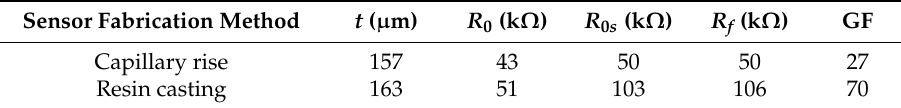
Table 2. Characteristics of the sensors produced via capillary rise and through the resin casting method: average thickness t , initial resistance R 0 before the cyclic test, starting resistance R 0 s before the monotonic test, final resistance R f after complete unloading and the gauge factor ( GF